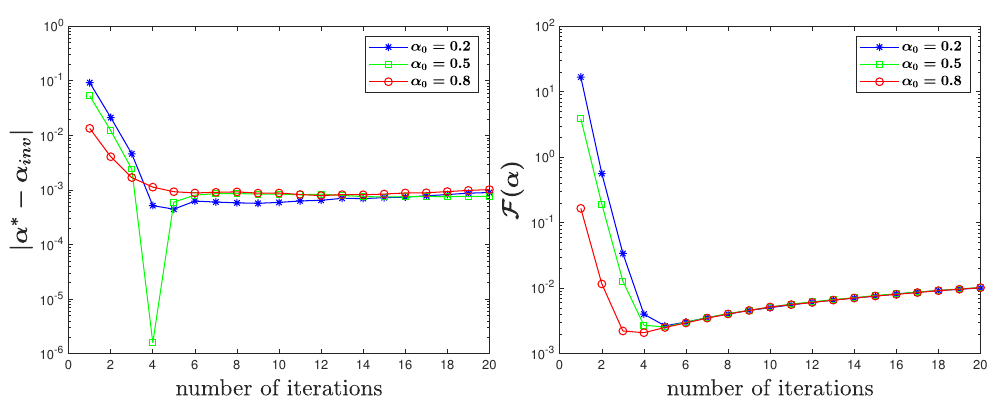
Figure 11. α ∗ = 0.75 for true data with 0.01% of noise in Test 4.